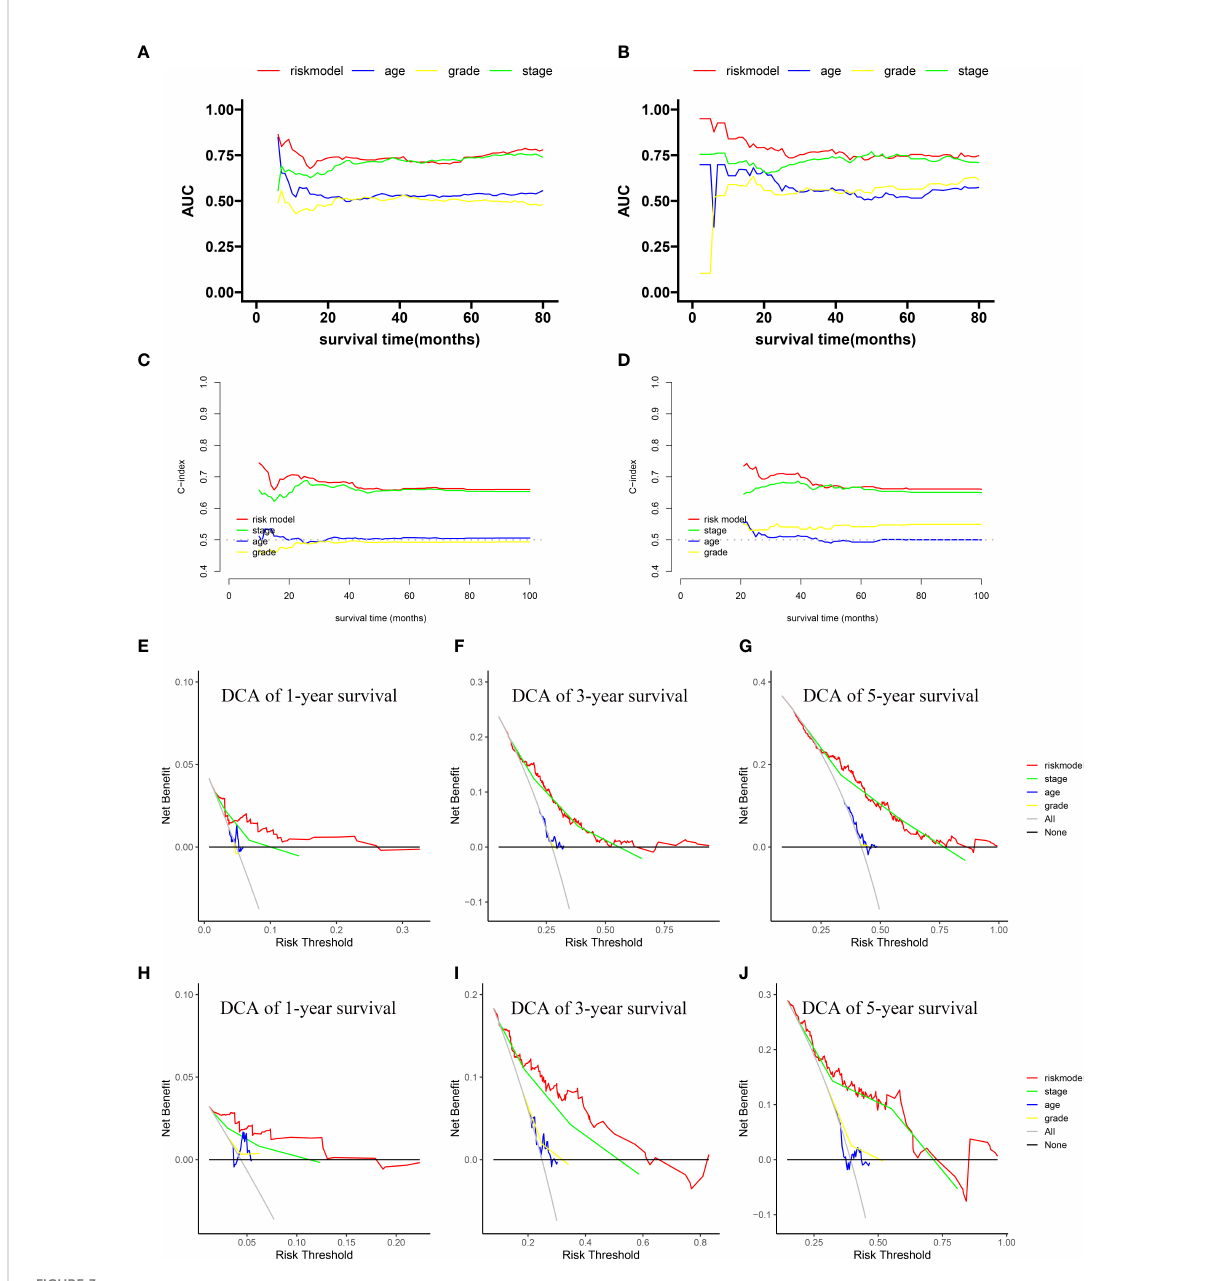
FIGURE 3 Comparison of the predictive accuracy and discrimination of the novel prognostic model with other clinical features. Time-dependent ROC in the training cohort (A) and validation cohort (B) . Continuous C-index curves in the training cohort (C) and validation cohort (D) . One-, 3-, and 5-year DCA plots in the training cohort (E – G) and validation cohort (H – J)